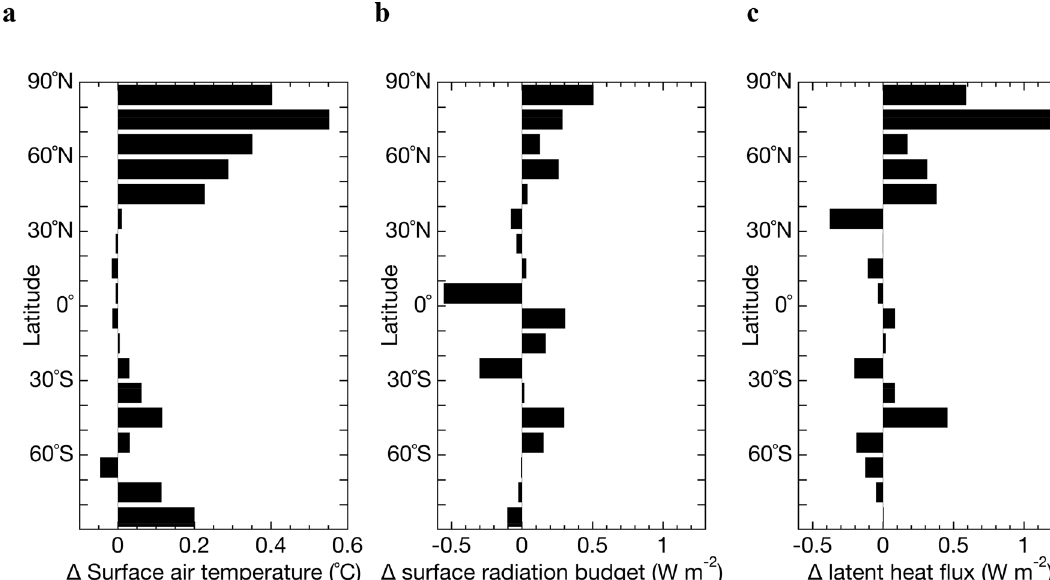
Figure 5. Factors of the temperature difference depending on CO 2 concentrations. The zonal averaged differences under doubled CO 2 concentration relative to the present in changes in the surface air temperature ( a ), shortwave plus longwave radiation budget at the surface (downward positive) ( b ), and latent heat flux ( c ) following reduction of SO 2 emissions from fuel sources to